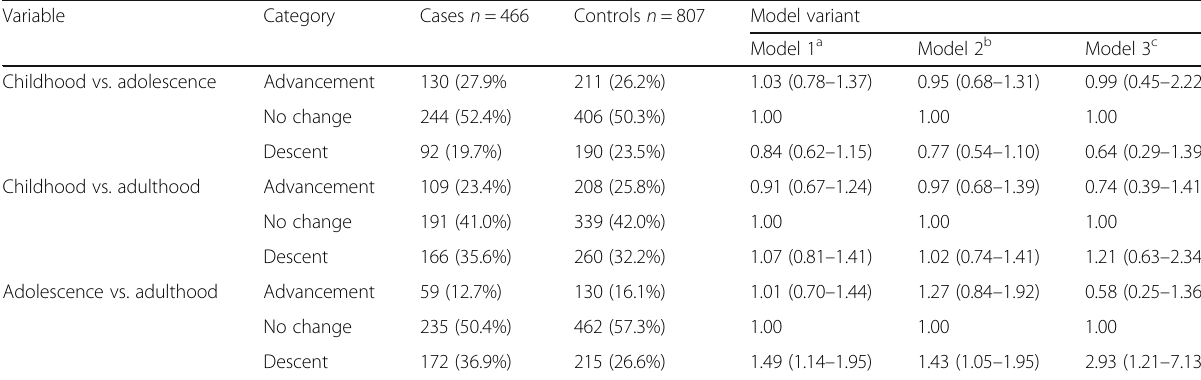
Table 2 Social mobility between childhood, adolescence and late adulthood. Analysis of risk score strata Variable